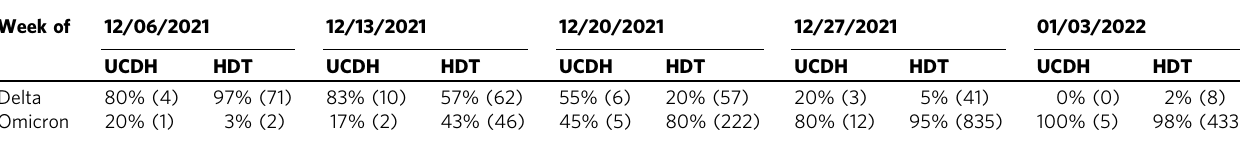
Table 2 Sequencing surveillance data from the UC Davis Health (UCDH) and genotyping surveillance data from Healthy Davis Together (HDT), showing when the Omicron variant overwhelmed Delta among COVID( + ) patients in our region.